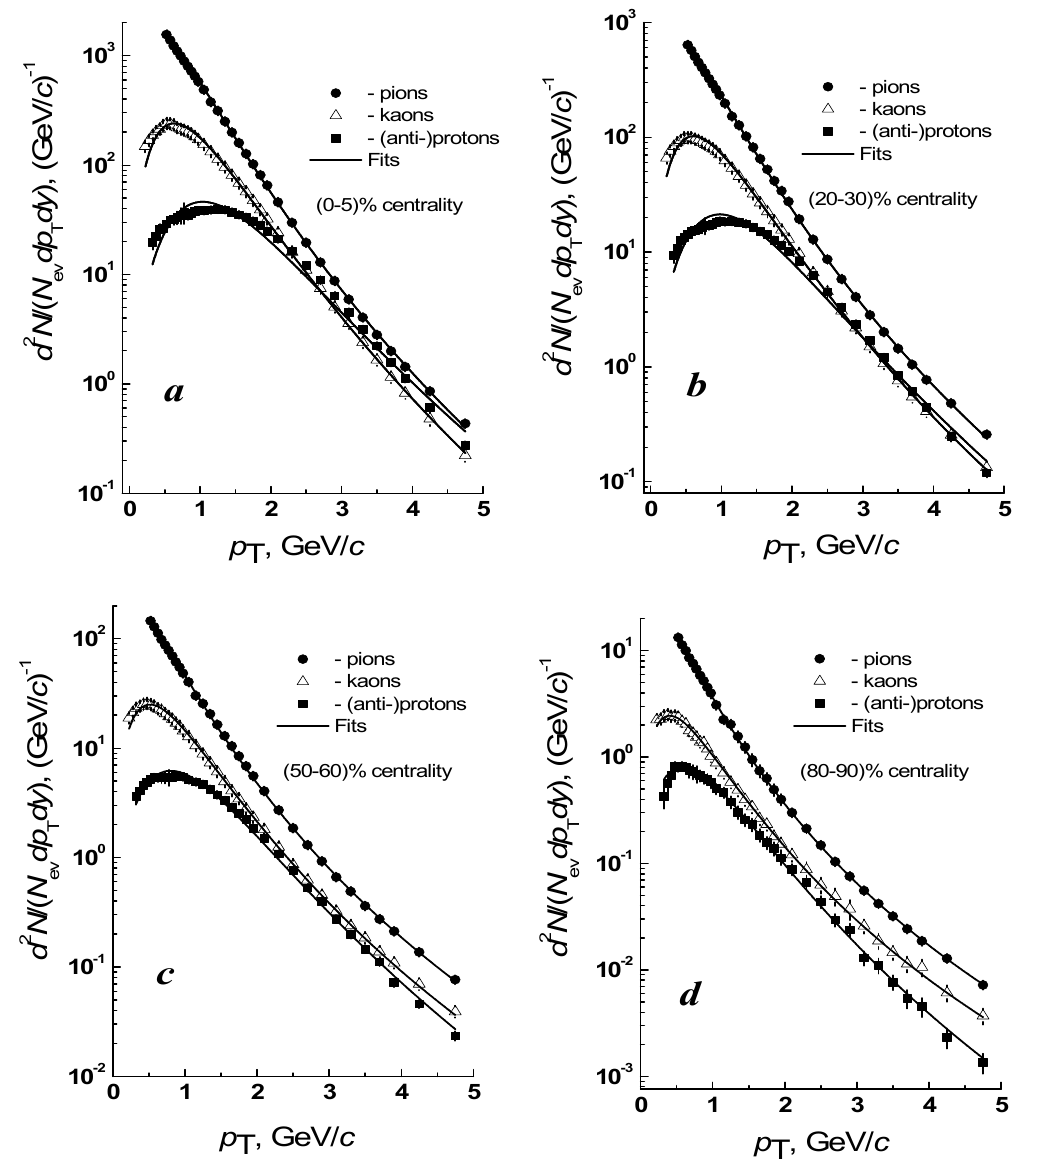
Figure 1. The obtained fit curves by consistent Tsallis function with transverse flow (Equation (5)) of the experimental midrapidity transverse momentum spectra of the charged pions ( • ), kaons ( ∆ ), and protons and antiprotons ( ▪ ) in Pb + Pb collisions at (cid:3493)𝑠 (cid:3041)(cid:3041) = 5.02 TeV at various centralities: 0–5% ( a ), 20 – 30% ( b ), 50–60% ( c ), and 80–90% ( d ).